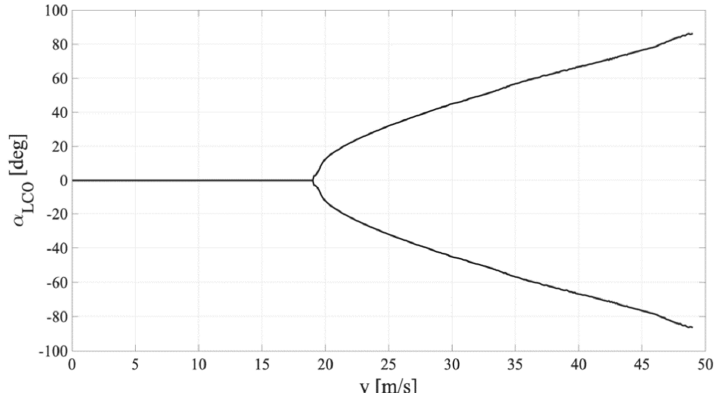
Figure 9. Limit cycle oscillation (LCO) amplitude variation with velocity.